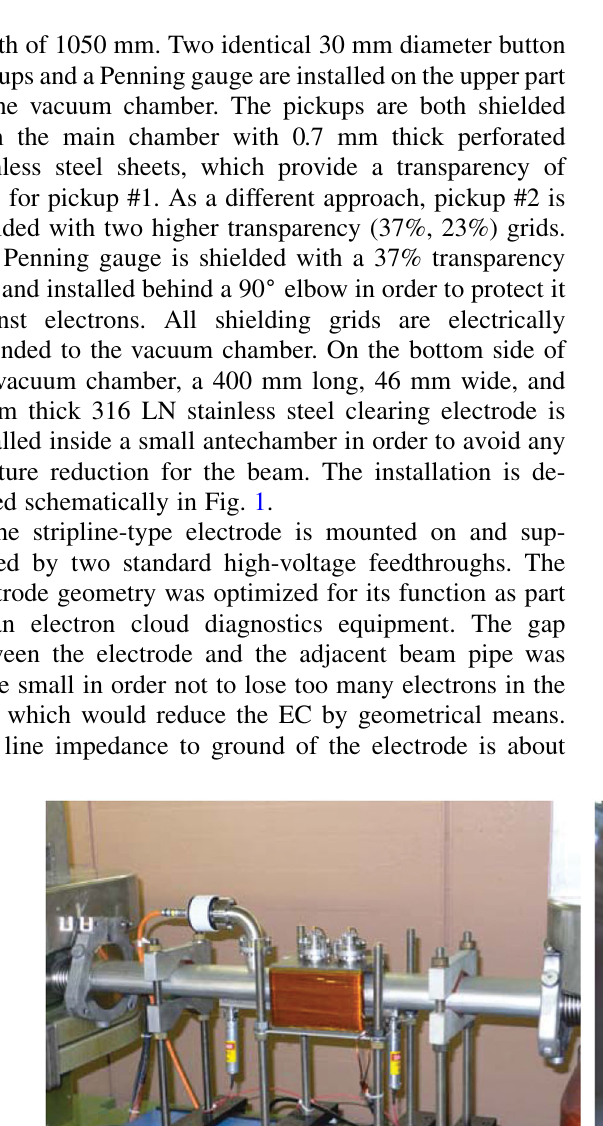
FIG. 1. (Color) Schematic view of the PS electron cloud experi- ment, comprising a shielded Penning gauge, two shielded button pickups (BPU), a stripline clearing electrode, and a dipole magnet (not sketched). Left: Longitudinal cut, right: transverse cut at the position of a BPU.